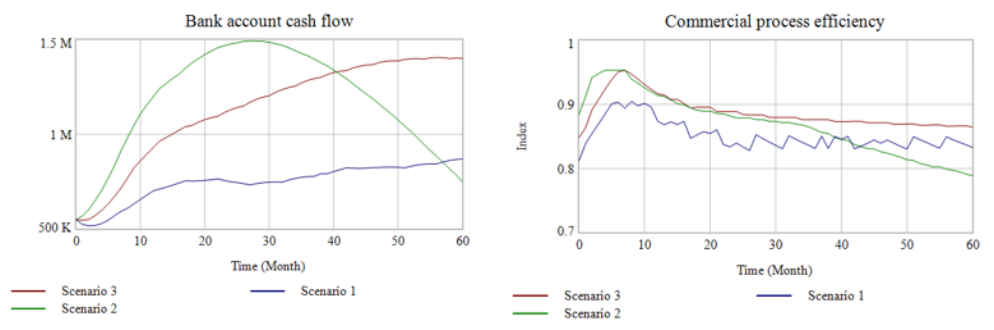
Fig. 11. Commercial process and cash flow efficiency (developed by the